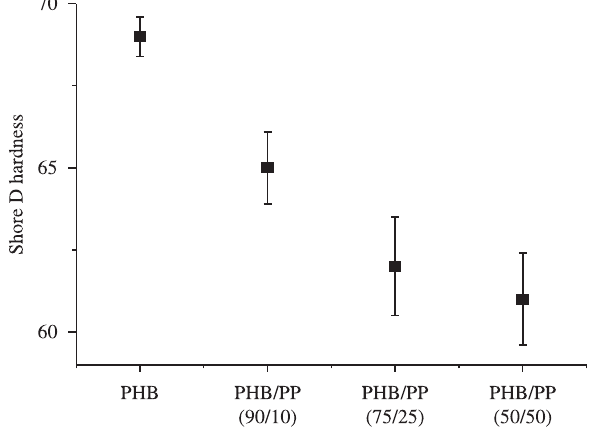
Figure 3. Shore D hardness values of PHB and PHB/PP blends.